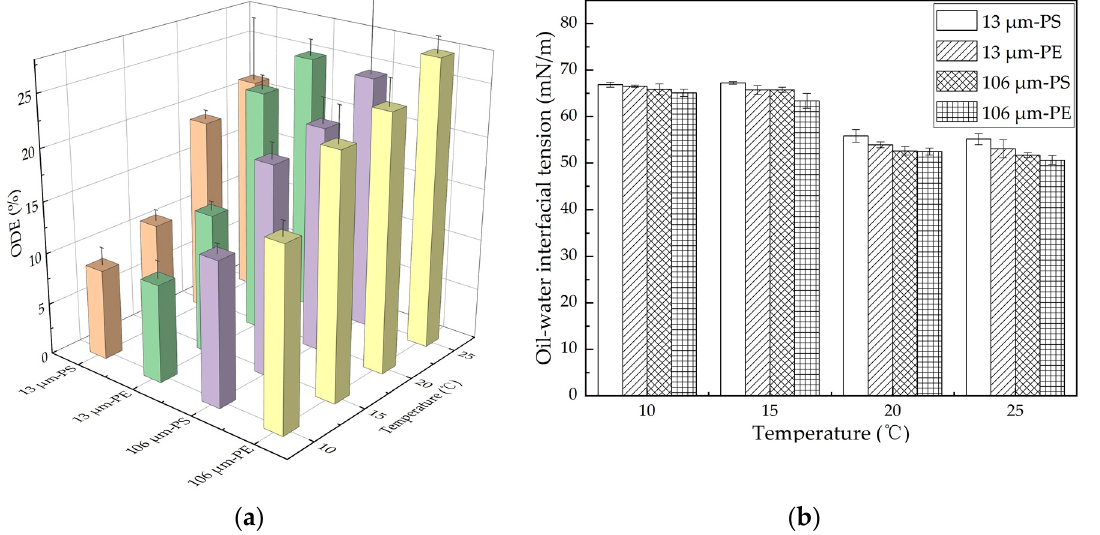
Figure 4. Impact of temperature on oil dispersion with different MPs in the oscillation experiment: ( a ) ODE ; ( b ) Oil–water interfacial tension. The error bar represents the standard deviation of the measurements of the three parallel samples. Orange, green, purple and yellow indicate 13 μ m-PS, 13 μ m-PE, 106 μ m-PS, 106 μ m-PE, represently.